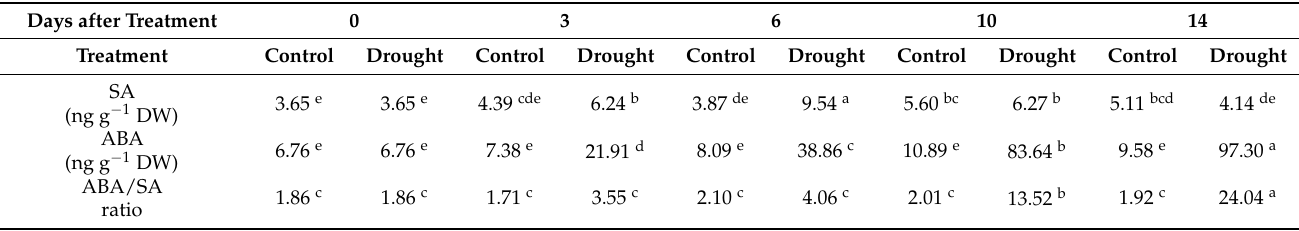
Values in a vertical column or a horizontal row followed by different letters are significantly different at p < 0.05 according to Duncan’s multiple range